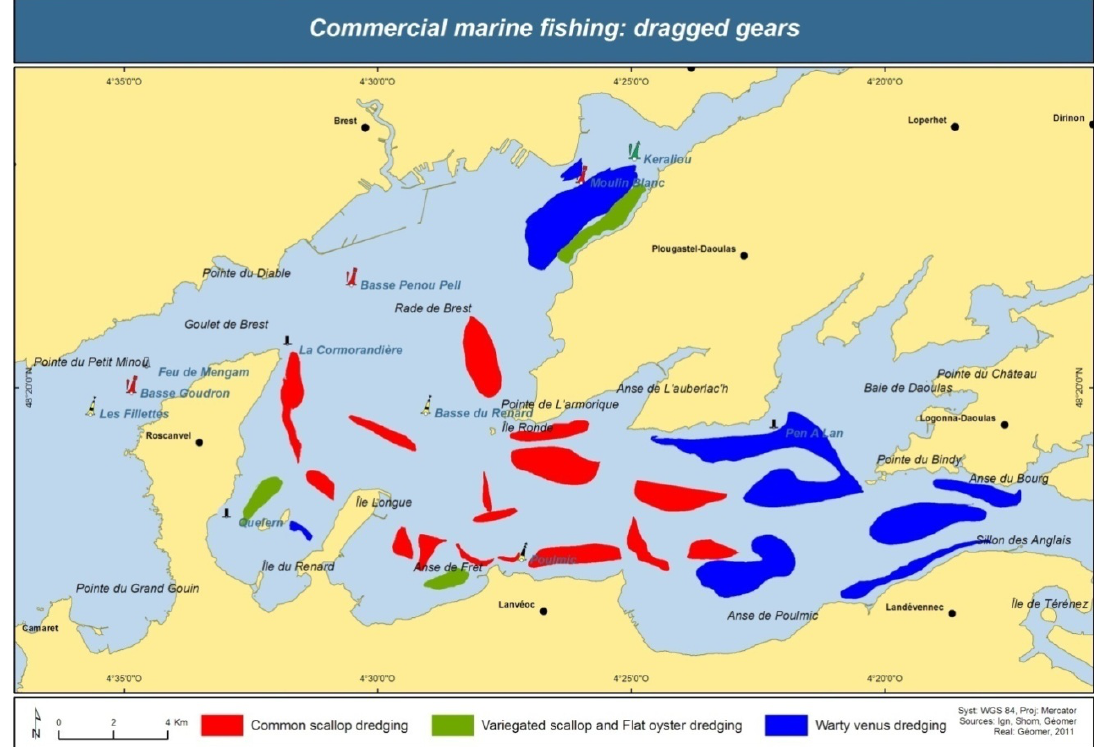
Figure 3. An example of an activity map.